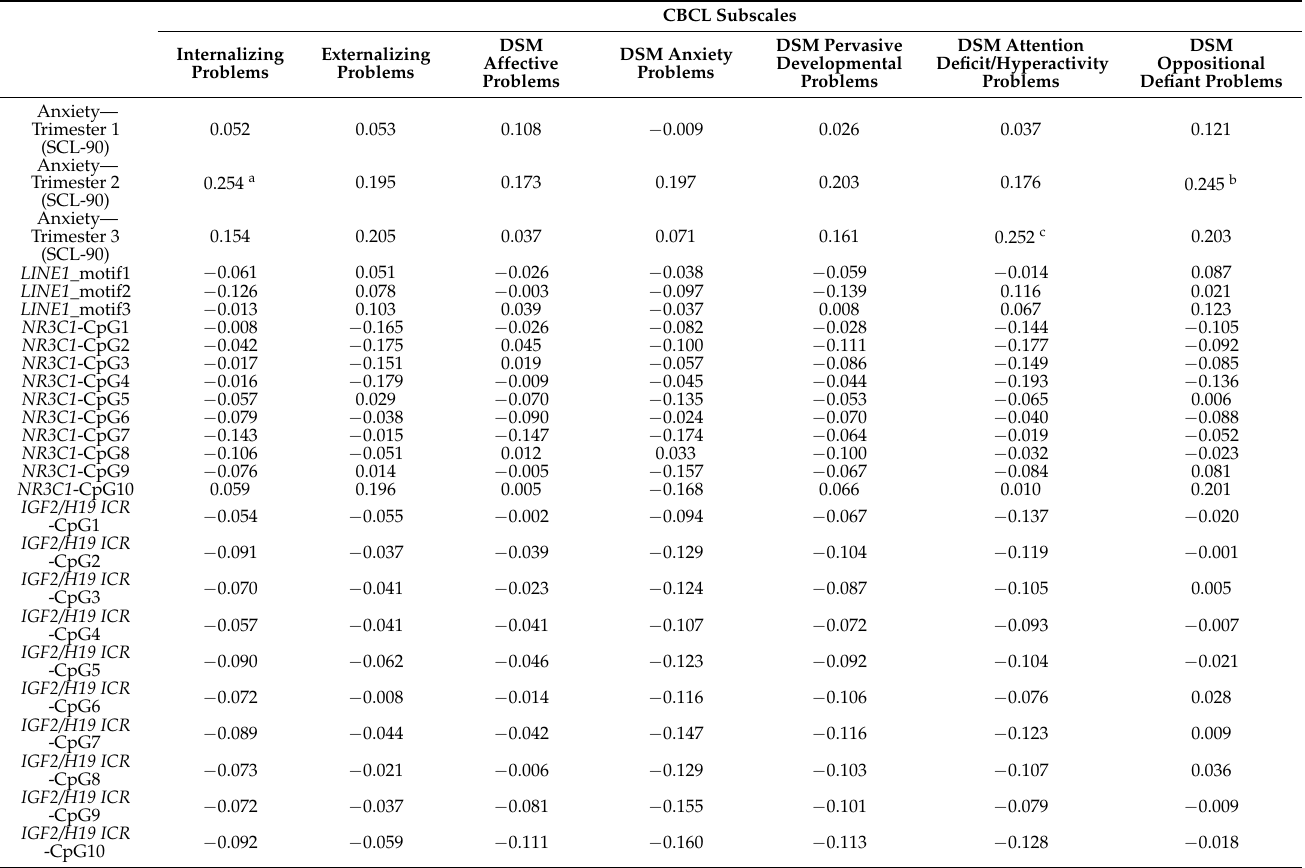
Table 2. Correlation of children’s behavioral measures with maternal anxiety during pregnancy and with DNA methyla- tion